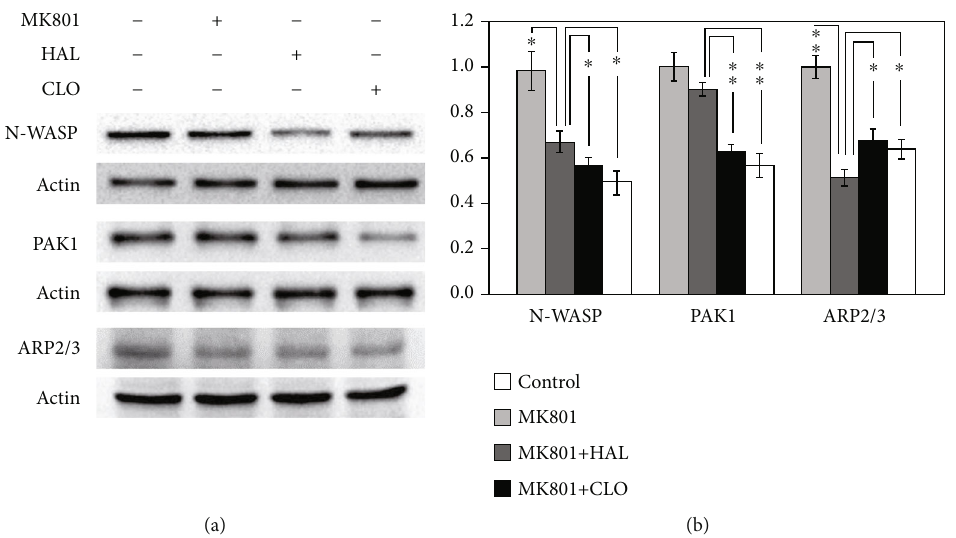
Figure 5: E ff ects of MK801, haloperidol (HAL), and clozapine (CLO) on N-WASP, PAK1, and ARP2/3 regulation in B35 cells. (a) Western blot revealing APD-induced changes in the expression of the N-WASP, PAK1, and ARP2/3 proteins in B35 cells. (b) Protein expression was quanti fi ed and normalized to beta-actin, and the relative expression of each protein chart bar was constructed from triplicate western blot data obtained from three di ff erent batches of APD-treated cells using ANOVA followed by Dunnett ’ s test ( ∗ p value < 0.05; ∗∗ p value < 0.01).